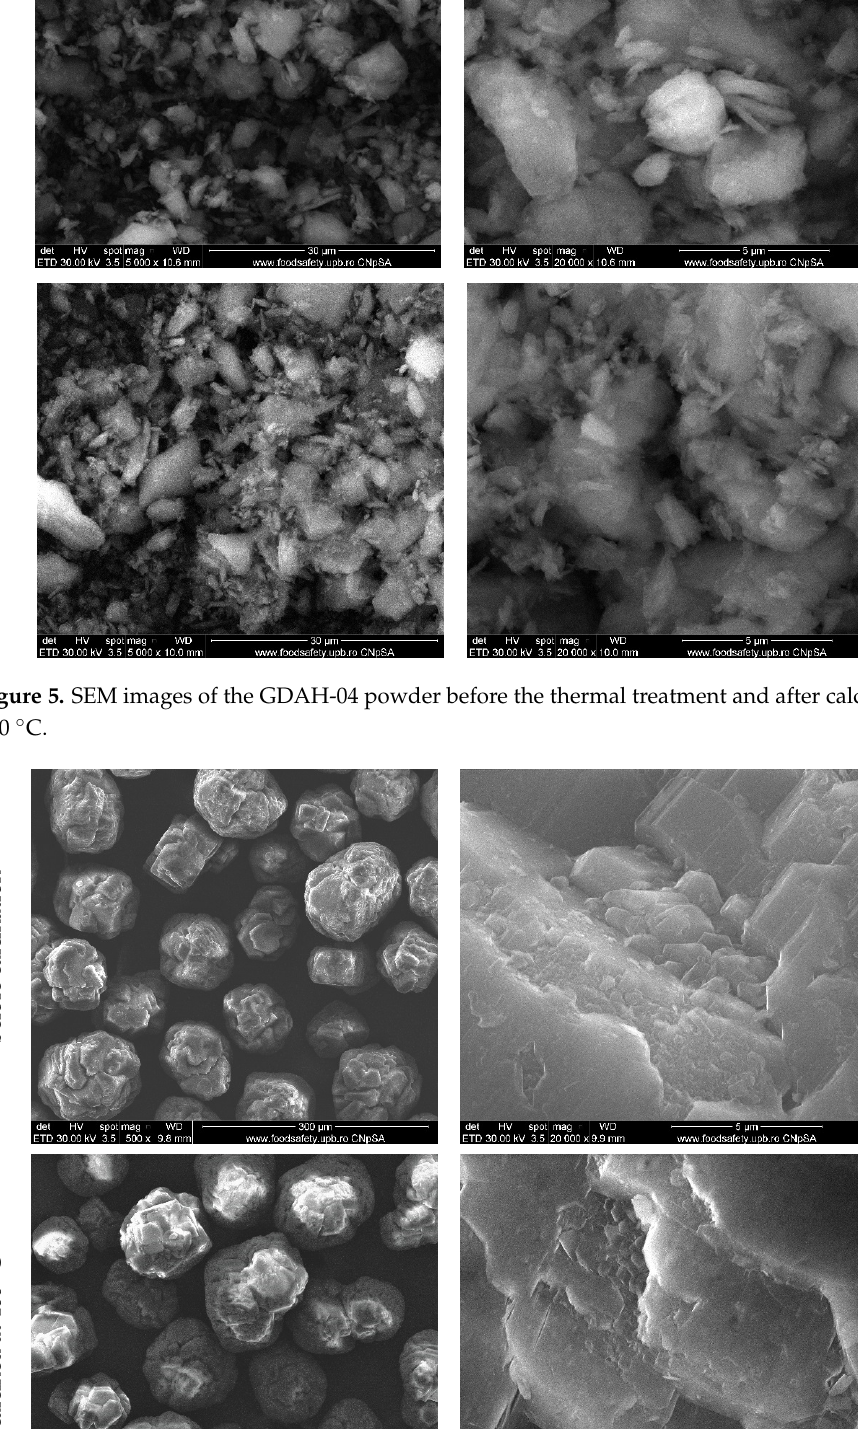
Figure 4. SEM images of the GDAH-03 powder before the thermal treatment and after calcination at 400 °C.